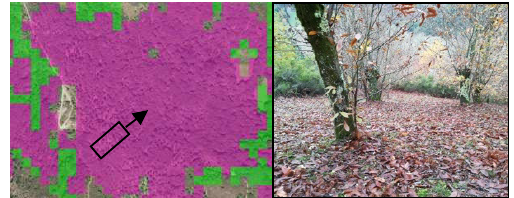
Figure 7. Left: Model 5 classification results overlapped with the MFE. Right: Field work picture. The figure shows an example of chestnut forest areas not included in the MFE chestnut polygons. Pink-colored areas are areas classified as chestnut while green-colored areas are classified as others. PNOA Reference image (PNOA,